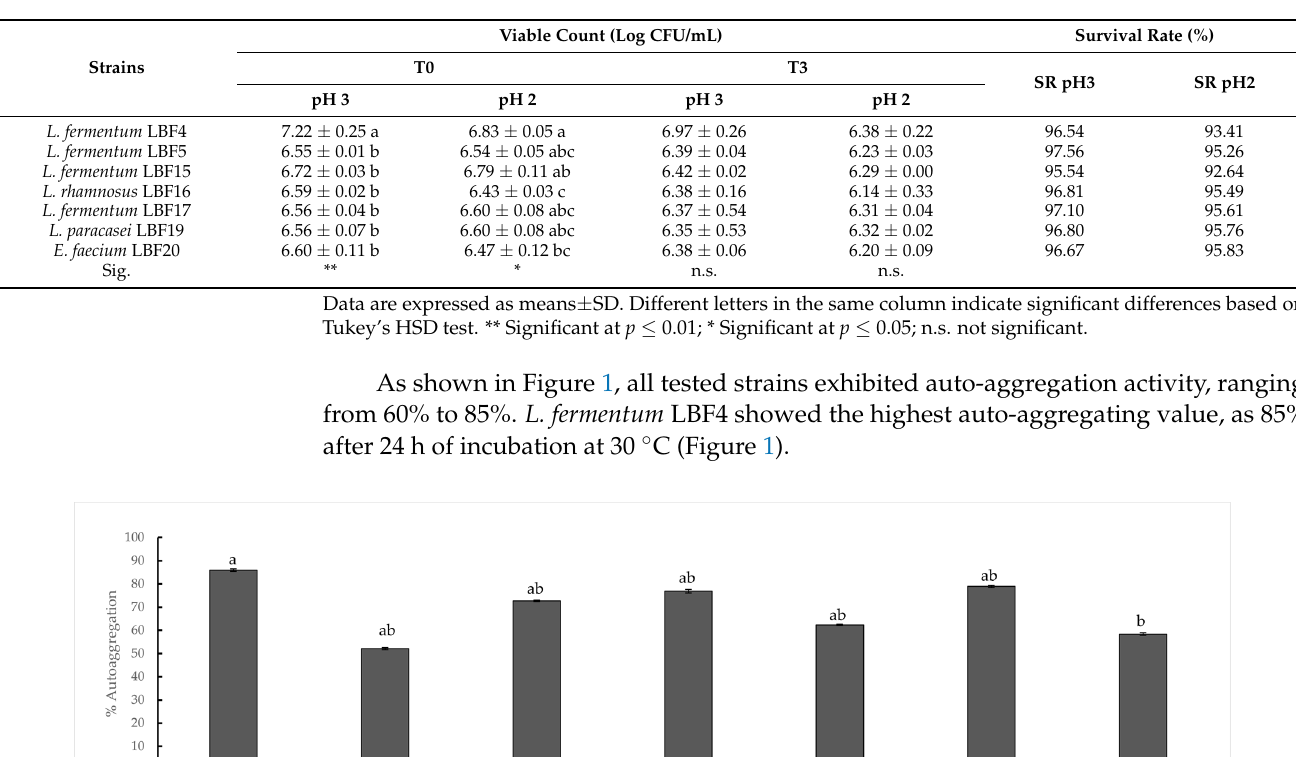
Table 3. Tolerance to pepsin at different pH values.